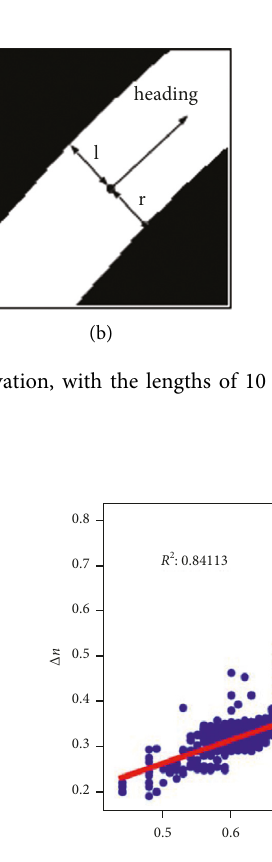
Figure 6: Results of linear regression between throttle and ∆ n , which is the distance advanced toward the heading direction.